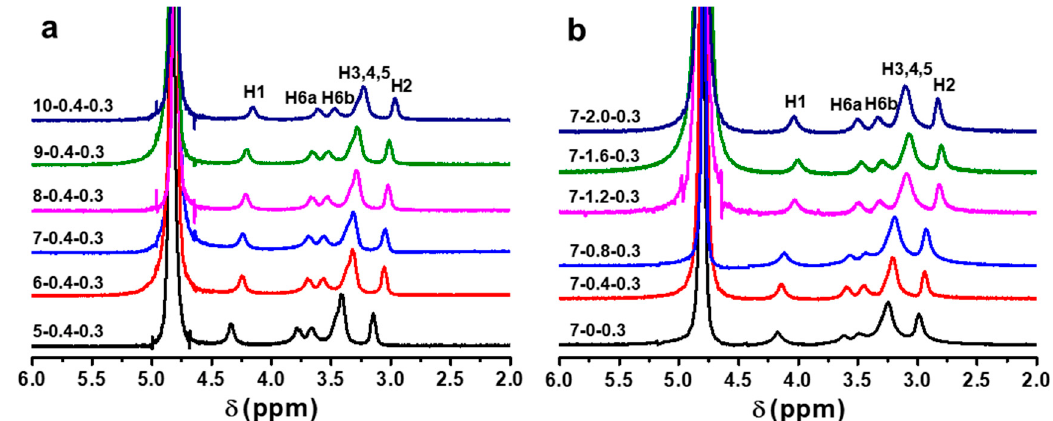
Figure 5. 1 H NMR spectra of CC (c = 0.3 wt%) in NaOH/ZnO/D 2 O with different ( a ) NaOH and ( b ) ZnO contents.